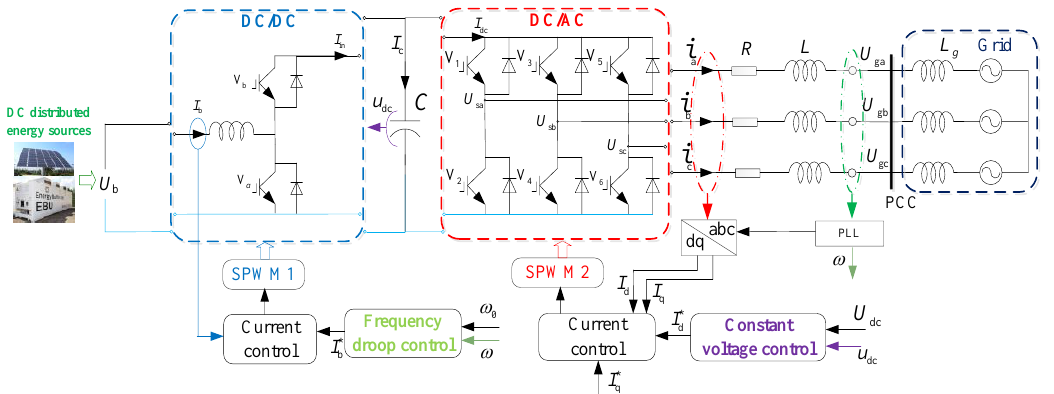
Figure 1. DC distributed power systems (DDPSs) based on frequency droop control.